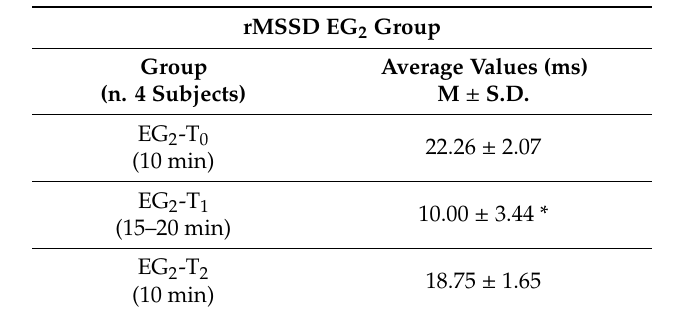
Table 6. Average values (M ± S.D.) of the rMSSD—expressed in ms—of Amiata donkeys (experimental group EG 2 ) at the times T 0 , T 1, and T 2 of the AAIs